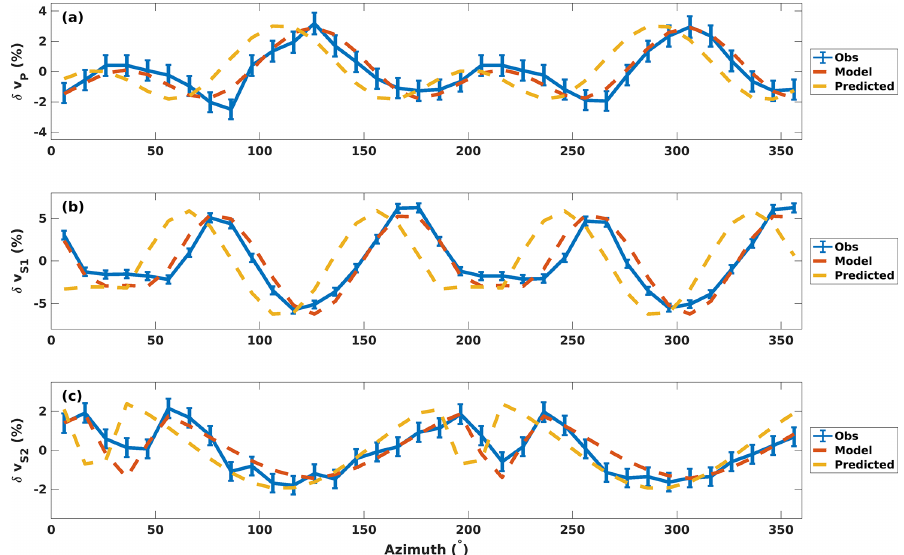
Figure 13. Observed, modelled and CPO-predicted anisotropy for sample 007. (a) δv P ; (b) δv S1 ; (c) δv S2